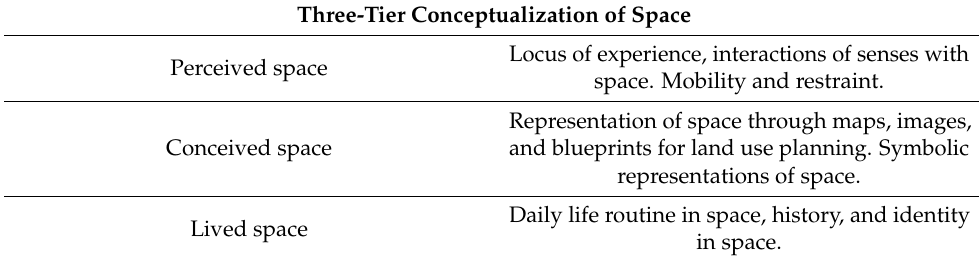
Table 1. Three-Tier Conceptualization of Space. Three-Tier Conceptualization of Space Locus of experience, interactions of senses with Perceived space space. Mobility and restraint. Representation of space through maps, images, Conceived space and blueprints for land use planning. Symbolic representations of space. Daily life routine in space, history, and identity Lived space in space. Authors’ compilations derived from Harvey